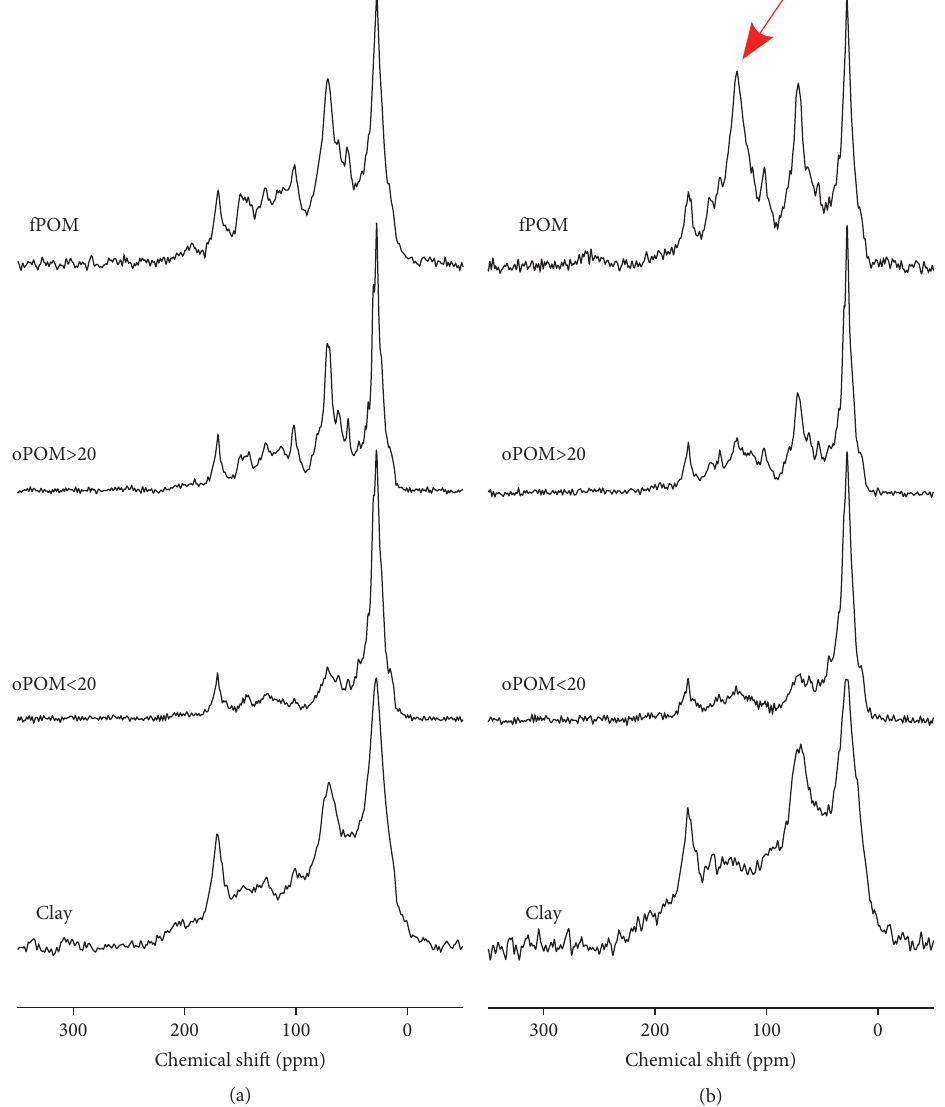
Figure 6: Site 5 Ferralsols: NMR spectra of fPOM, oPOM, and clay fractions from the B1 horizons (uppermost mineral soil horizons) under rainforest (a) and mixed forest (b). The prominent aryl-C peak in the fPOM fraction under mixed forest is